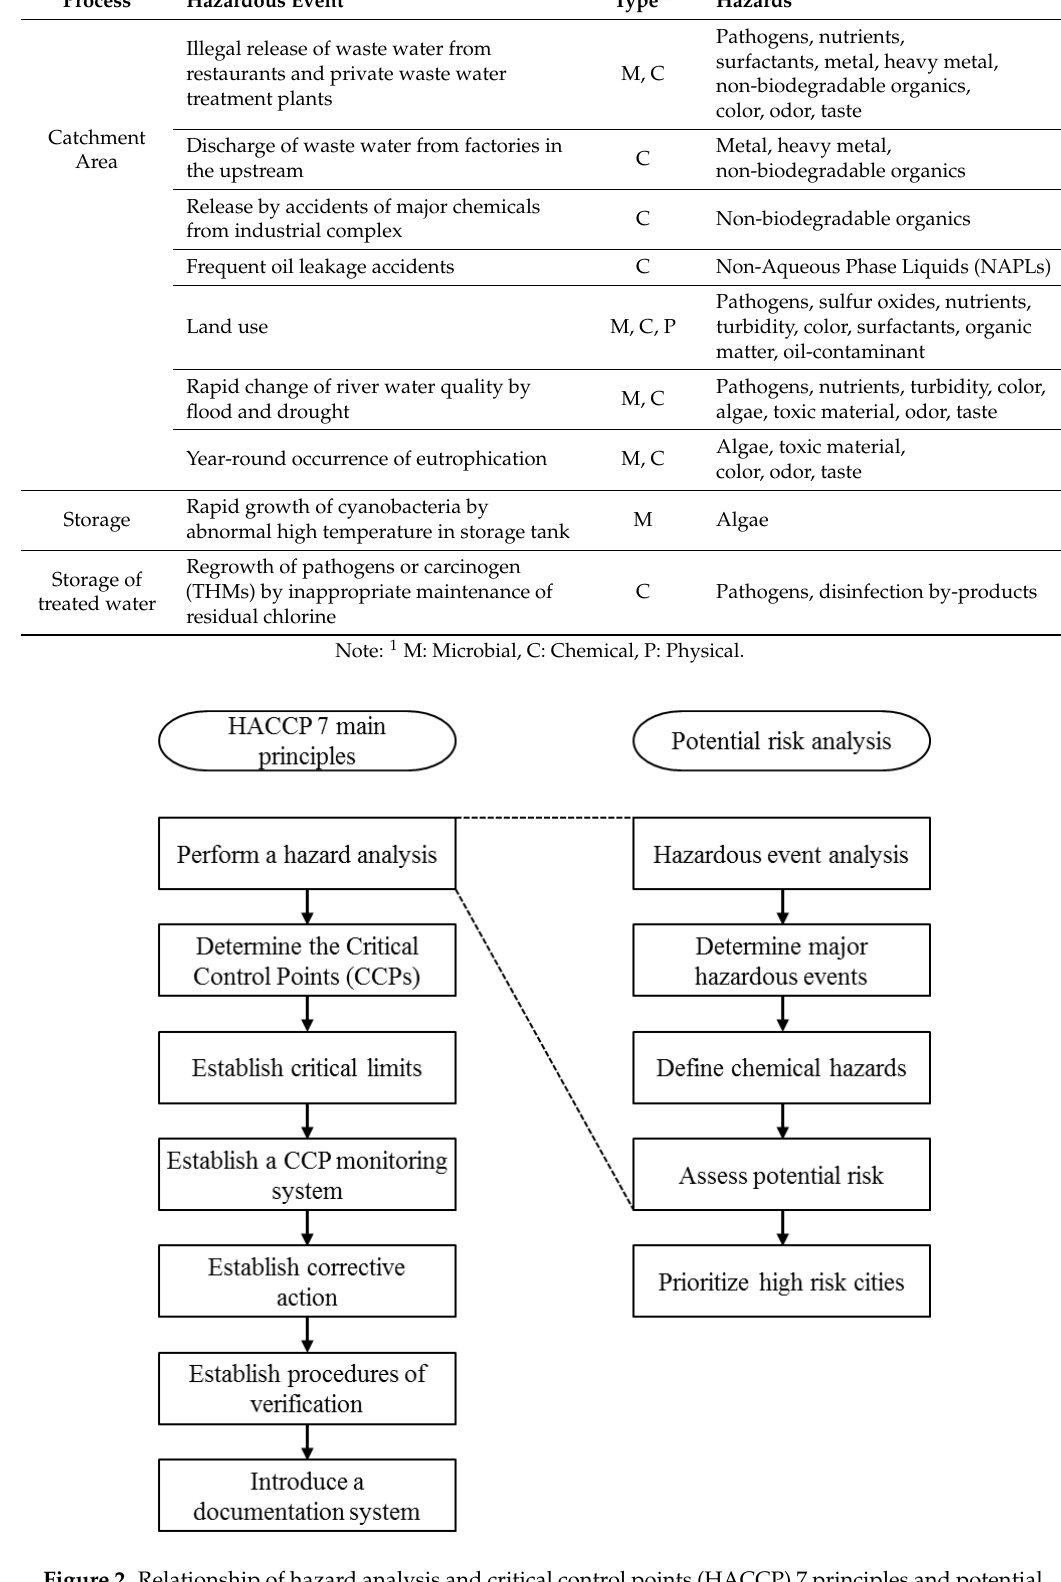
Table 1. Major hazardous events in the process of drinking water production [10].